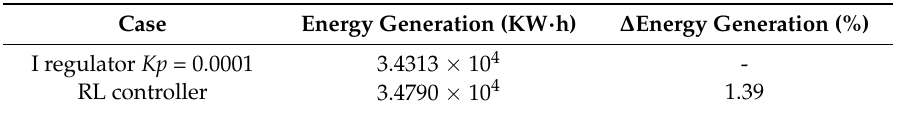
Table 2. Electrical energy generation comparison of the conventional and the proposed RL based yaw control